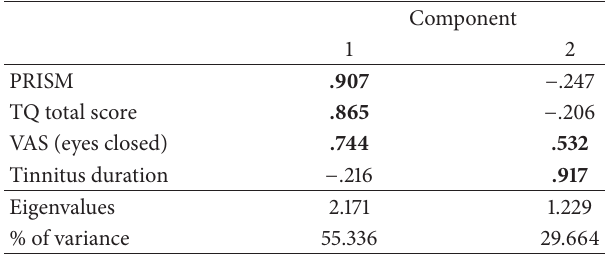
Table 3: Rotated factor loadings.